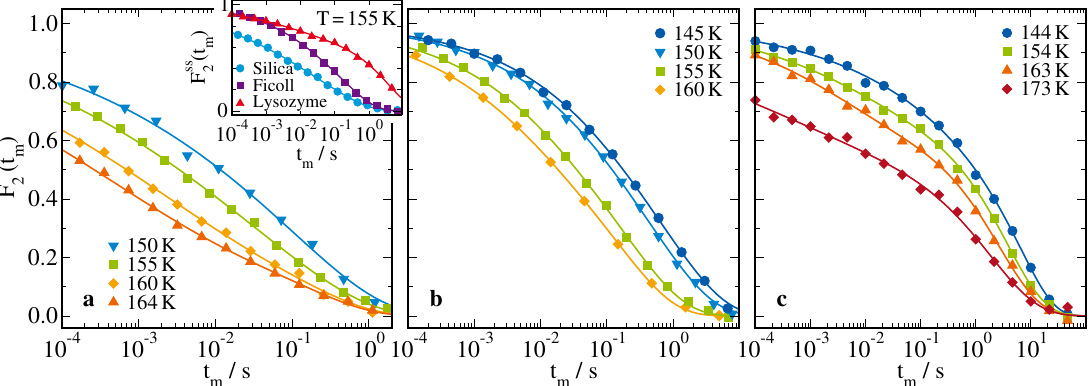
( t m ) of 66mol% D Figure 7. Correlation functions F ss 2 O-DMSO- h 6 solution in ( a ) in silica pores with a 2 diameter of d = 2.8nm , ( b ) ficoll at a solution mass fractions of w s = 70wt%, and ( c ) lysozyme at a solvation level of s = 0.68 g sol / g lys . In all measurements, the evolution times were set to t e = 4–5 µ s to ( t m ) ∝ F ( t m ) . The lines are fits to Equation (7). The inset compares F ss ( t m ) of the studied achieve F ss 2 2 2 samples at T =